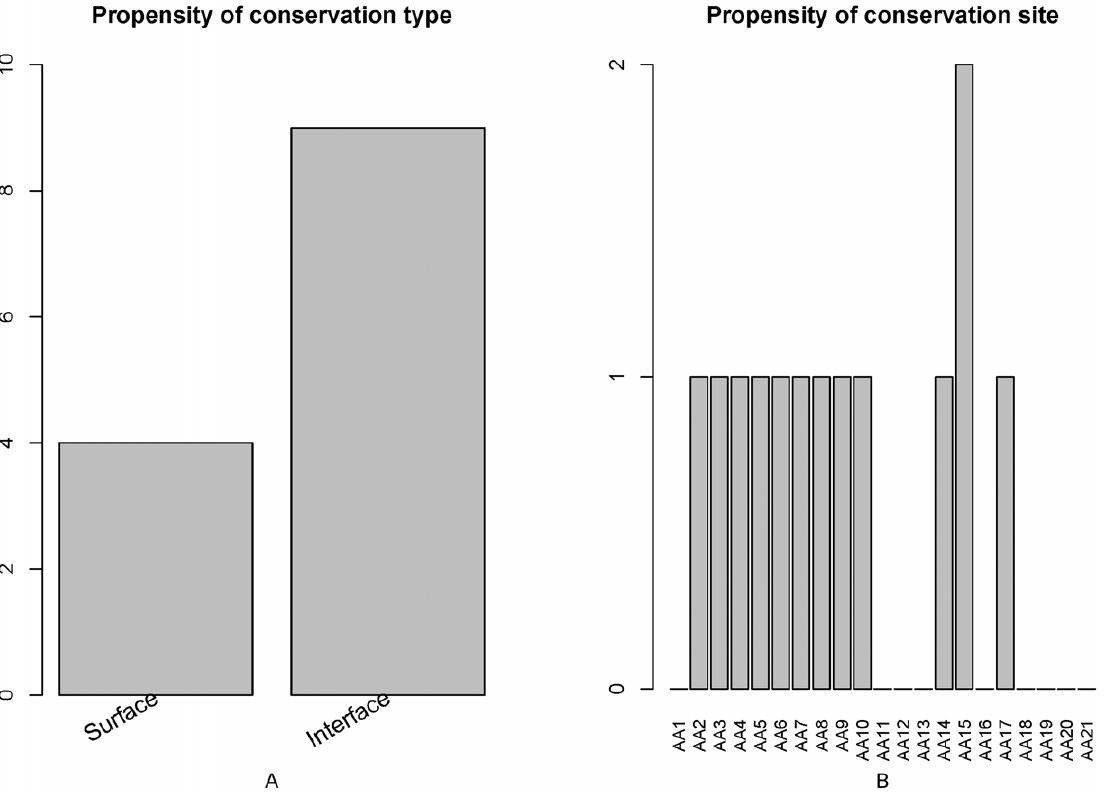
Figure 7. Feature and site specific distribution of the propensity of amino acid to be conserved at protein-protein interface and protein surface features in the optimal feature set. (A) Feature distribution of these features in the optimal feature set. Propensity of amino acid to be conserved at protein-protein interface influence more on PCA modification site determination and propensity of amino acid to be conserved at protein surface also can influence PCA modification site determination. (B) Site-specific distribution of these features in the optimal feature set. Propensity of amino acid to be conserved at protein-protein interface and protein surface features at site 15, 2–10, 14 and 17 influence more on PCA modification site determination.